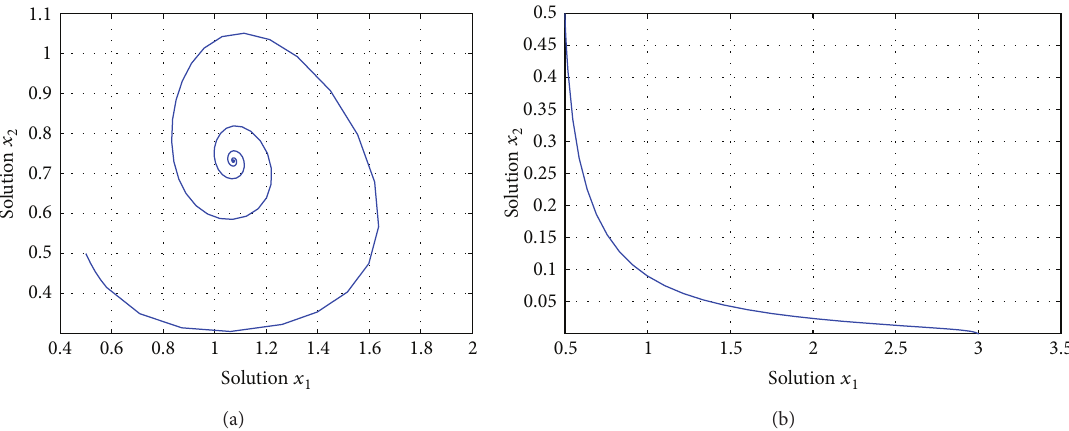
Figure 1: The dynamical behavior of model (1): (a) a stable focus ((𝑟 1 𝑎 22 +𝑟 2 𝑎 12 )/(𝑎 11 𝑎 22 +𝑎 12 𝑎 21 ),(𝑟 1 𝑎 21 −𝑟 2 𝑎 11 )/(𝑎 11 𝑎 22 +𝑎 12 𝑎 21 )) ; (b) a stable nod (𝑟 1 /𝑎 11 , 0)